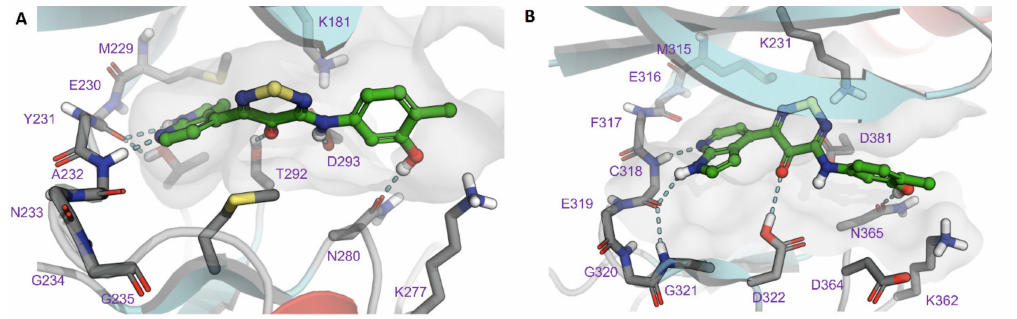
Figure 7. Molecular modeling of thiadiazinone 17 on MIBS kinome profiling hits: ( A ) AKT2 and ( B ) STK35.